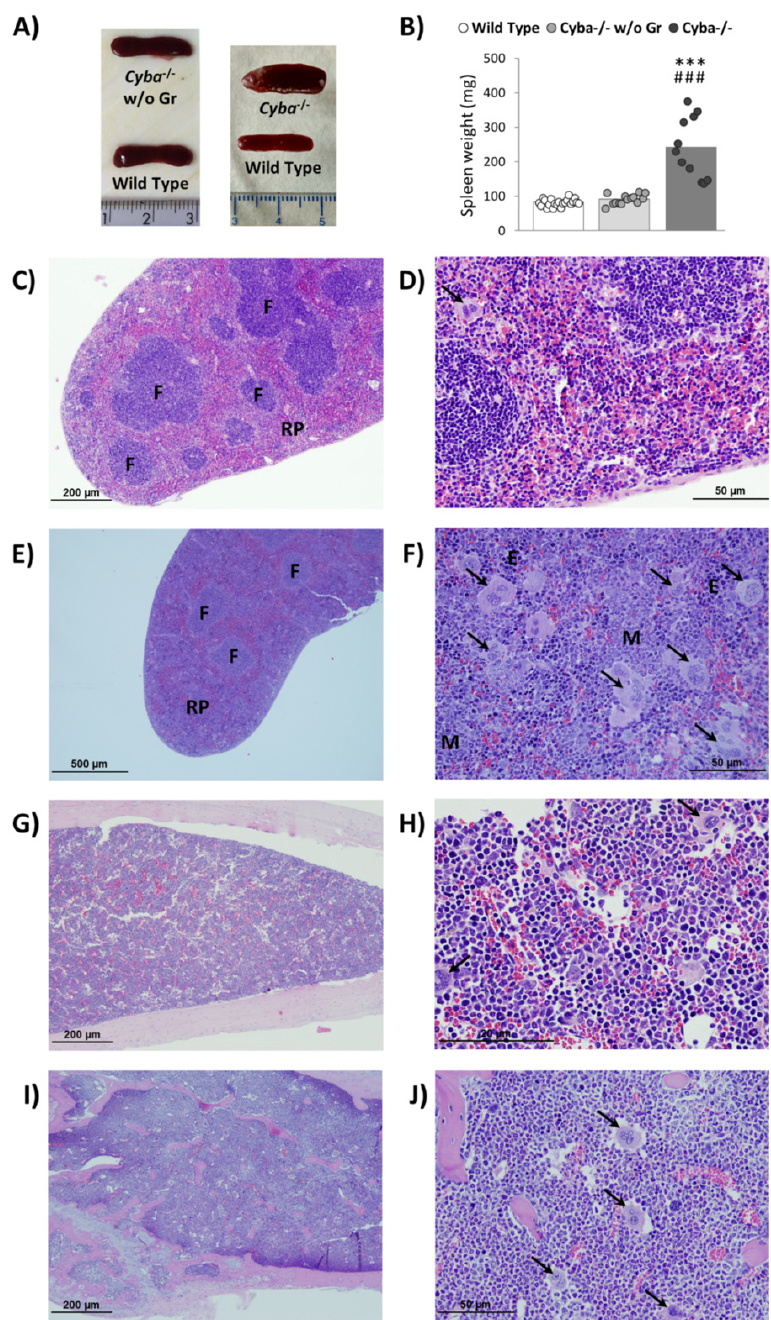
Figure 2. Cyba − / − mice with abscesses showed splenomegaly and myeloid hyperplasia. ( A ) Spleen of control mice, Cyba − / − mice without granuloma ( Cyba − / − w/o Gr) and granuloma-bearing Cyba − / − mice ( Cyba − / − ). ( B ) Difference in weight of spleen between Cyba − / − mice without gran- uloma ( Cyba − / − w/o Gr; n = 14), granuloma-bearing Cyba − / − mice ( Cyba − / − ; n = 11), and con- trol mice (n = 21). *** p < 0.001 vs. control; ### p < 0.001 vs. Cyba − / − mice without granuloma. ( C – F ) Haematoxylin–eosin staining of spleens in control ( C , D ) and granuloma-bearing Cyba − / − ( E , F ) mice. RP: red pulp. F: white pulp follicles. M: myeloid cells. E: erythroid cells. Black arrows: megakaryocytes. (n = 4). ( G – J ) Haematoxylin–eosin staining of femur bone marrow in control ( G , H ) and granuloma-bearing Cyba − / − ( I , J ) mice. Black arrows: megakaryocytes. (n = 3). Magnifica- tion: 8 × ( C ), 40 × ( D ), 4 × ( E ), 40 × ( F ), 8 × ( G ), 60 × ( H ), 8 × ( I ), 40 × ( J